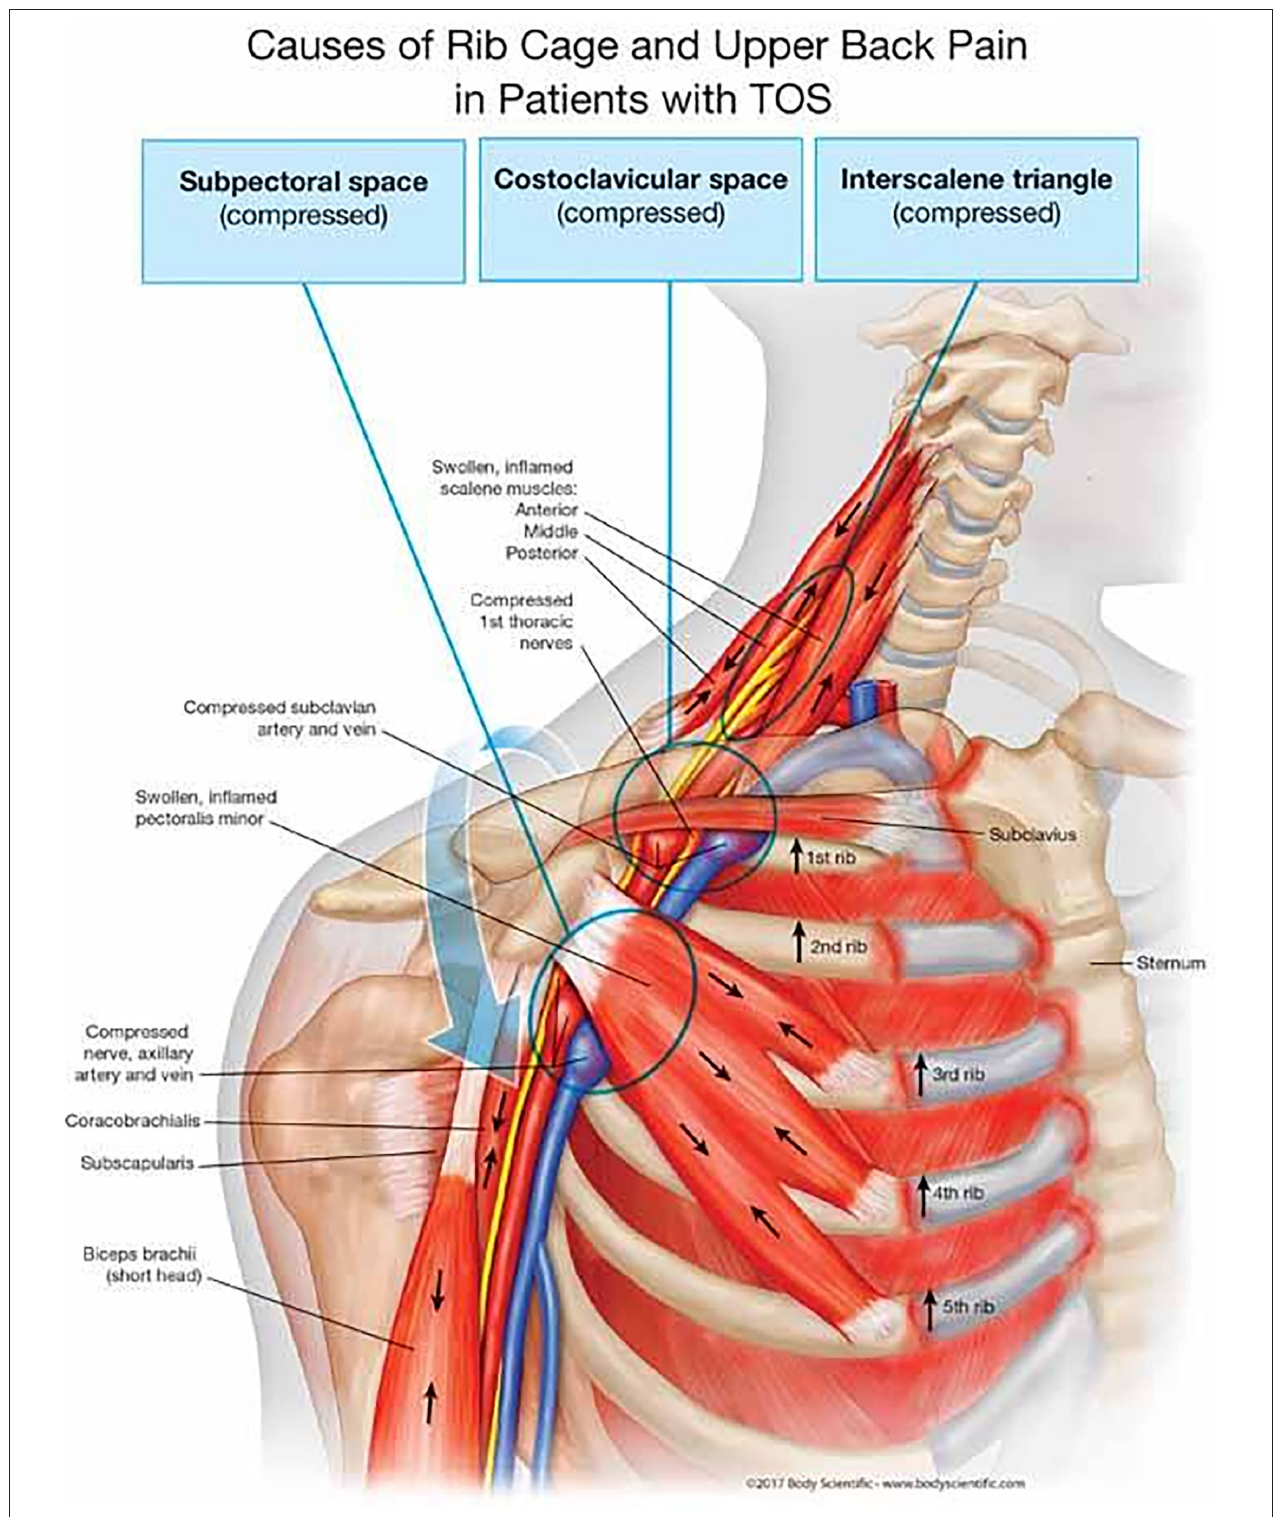
FIGURE 1 | Anatomical spaces involved in